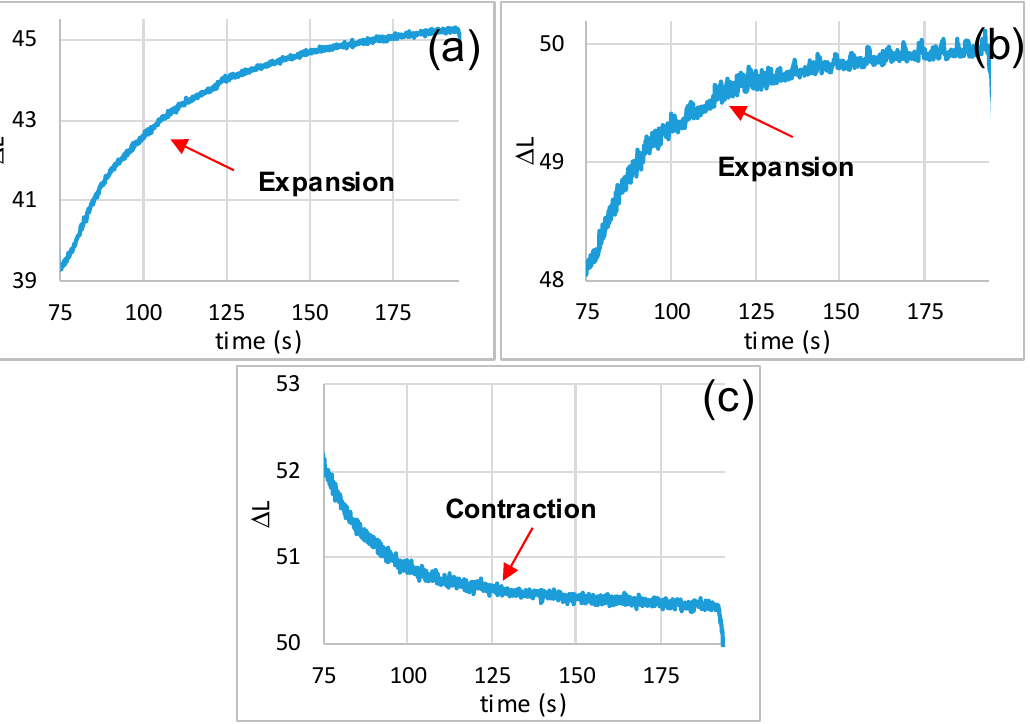
Figure 8. Δ L vs. time curves obtained experimentally during IBT for 120 s at temperature: ( a ) 425 °C, ( b ) 450 °C and ( c ) 475 °C.